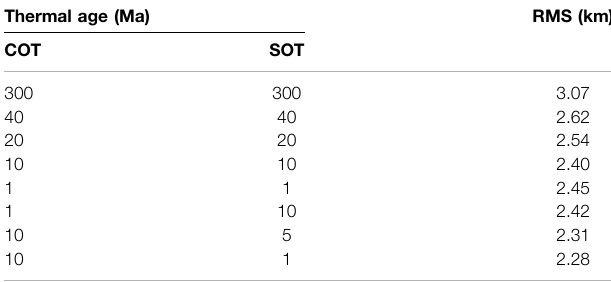
TABLE 2 | The root mean square (RMS) between gravity inversion result and seismic interpretation when setting different thermal ages for the central Okinawa Trough (COT) and the southern Okinawa Trough (SOT).